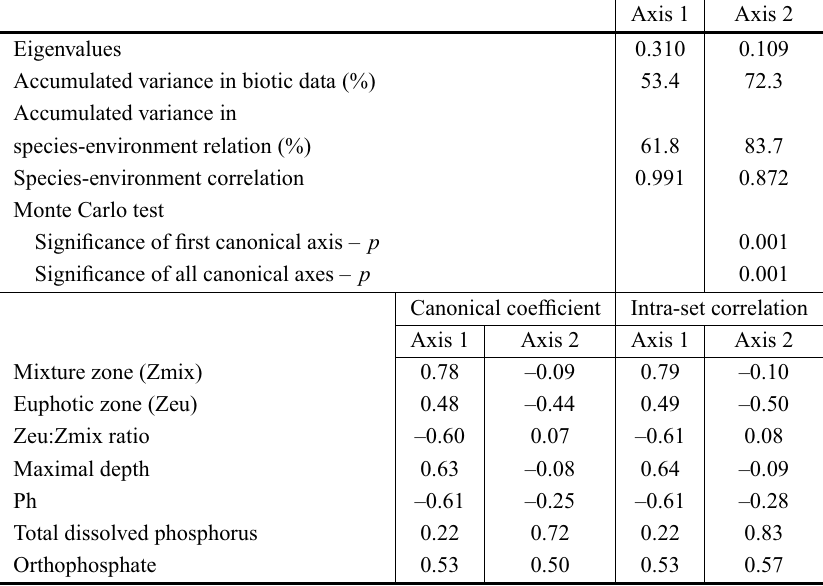
Statistical summary and correlation coefficients for phytoplankton species and abiotic variables on the first two CCA axes for the Arcoverde and Pedra reservoirs, Pernambuco State,